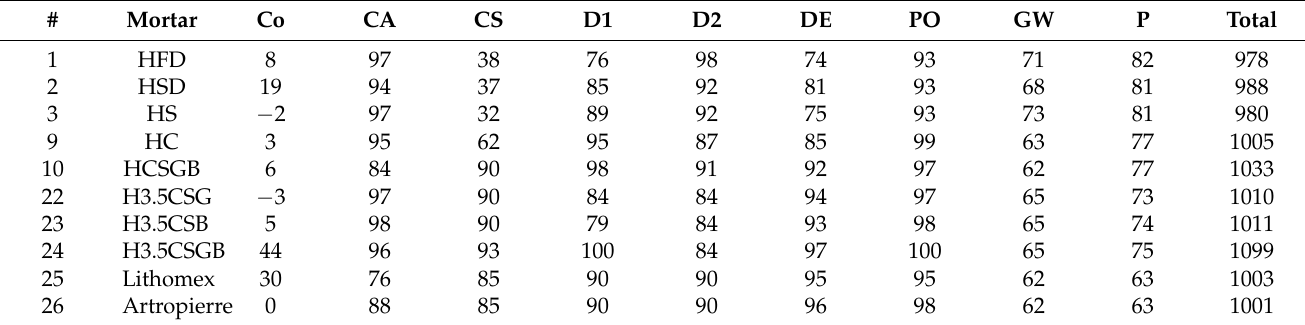
Table 11. Score of selected mortars including weighing coefficients (Equation